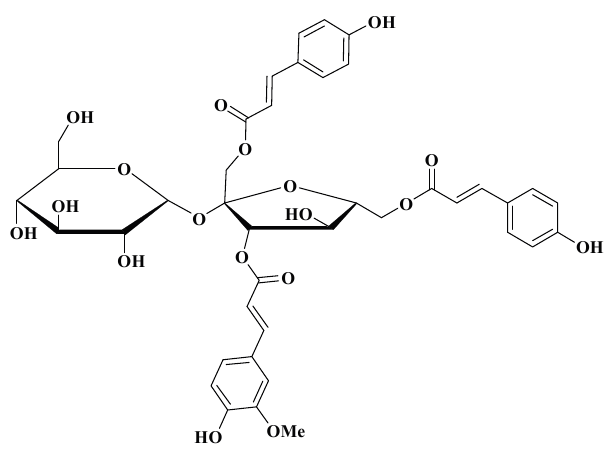
Figure 1. The chemical structure of tatariside G